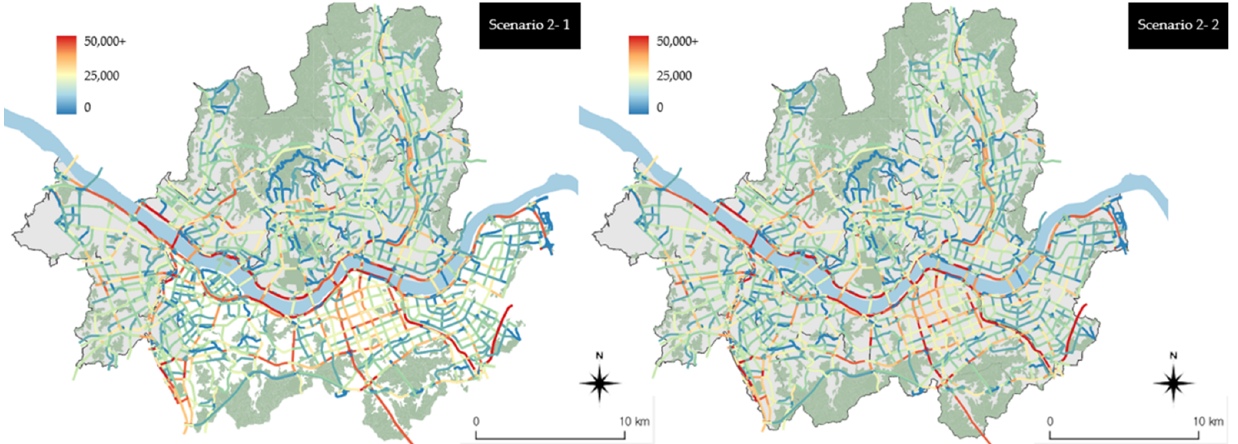
Figure 8. Scenario 2 vehicle emissions by the link units.